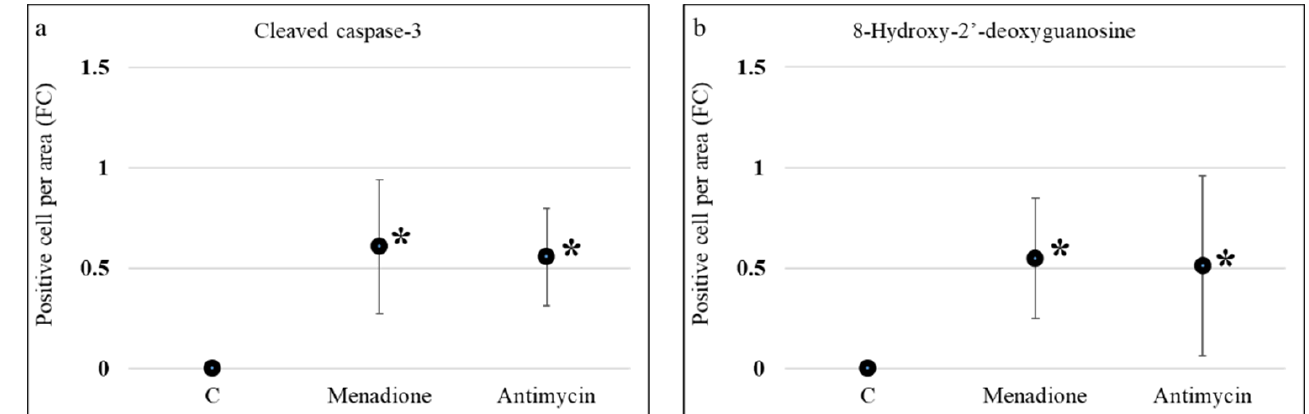
Figure 2. Effect of menadione and antimycin on apoptosis and DNA damage in first trimester human placental explants. Explants from 7–12 weeks of gestation ( n = 12) were cultured for 5 days in media with 10% v / v FBS and 1% v / v Antibiotic-Antimycotic and then treated with 120 µ M menadione, 480 µ M antimycin or 0.1% ethanol (vehicle control) for 24 h. Immunohistochemical labelling for ( a ) apoptosis (cleaved caspase-3) or ( b ) DNA damage (8-hydroxy-2’-deoxyguanosine) was performed. Eight randomly selected regions per explant were used for quantification and statistical analyses. Data are presented as a fold change (FC) relative to control ± standard error. Statistical significance was assessed using Generalised Estimating Equations with independence correlation structure with log 2-transformed positive stain per area to estimate fold change compared to controls followed by pre-specified post-hoc Bonferroni adjusted multiple comparisons. * Indicates statistically different ( p < 0.05) from